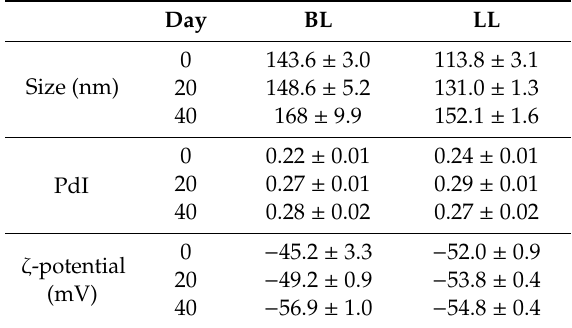
Table 1. Blank nanoliposomes (BL) and naringin-loaded nanoliposomes (LL) mean particle size, polydispersity index (PdI), and ζ -potential at day 0, 20, and 40.